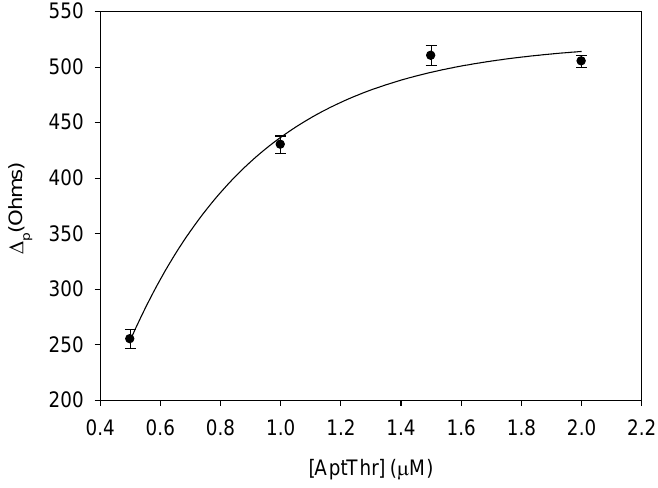
Figure 3. Optimization of the concentration of Apt-Thr. Uncertainty values corresponding to replicated experiments (n = 5).